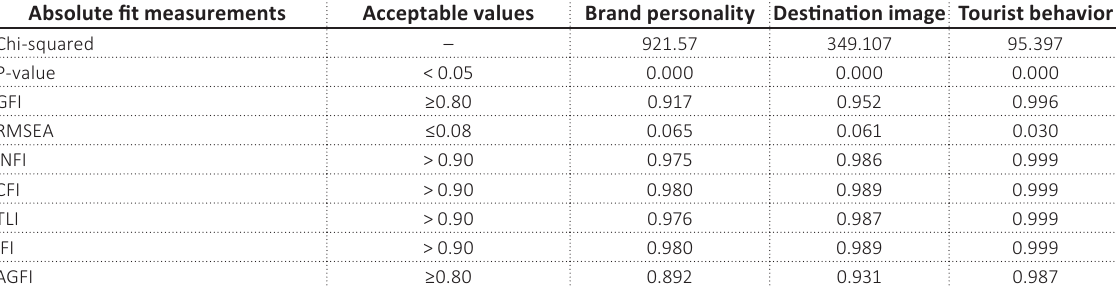
Table 1. Confirmatory analysis values